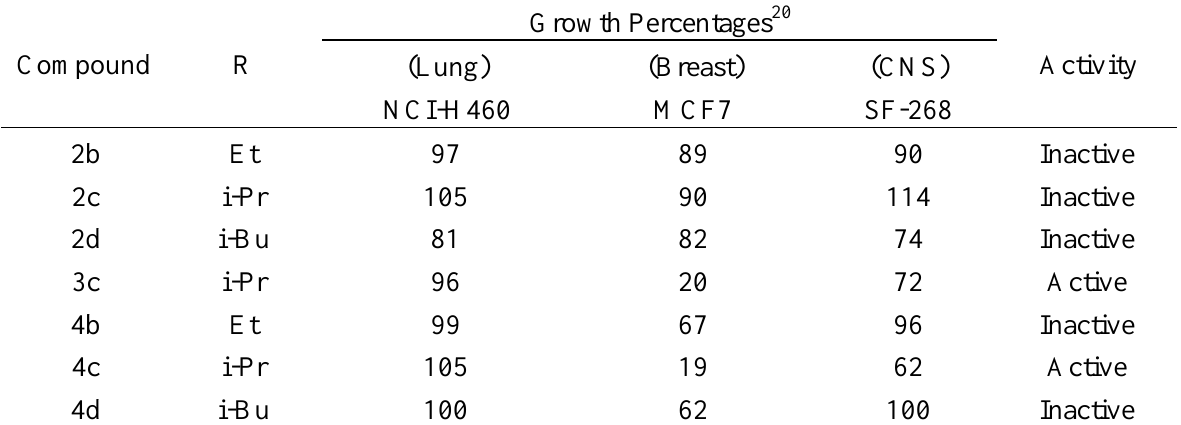
Table 1 . In vitro cytotoxic activity of selected OPIC derivatives against three cell